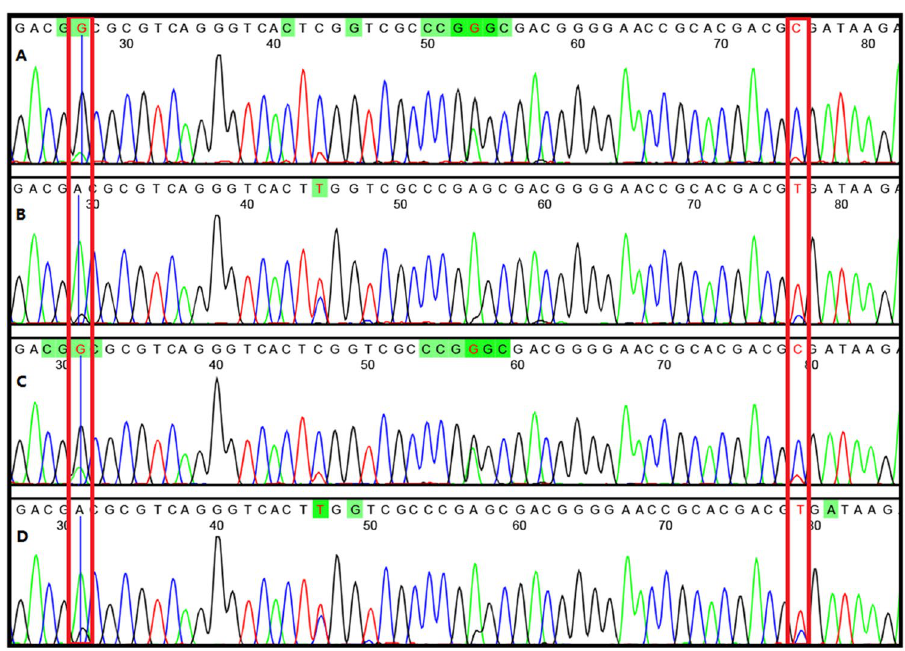
Figure 4. Double peaks of the artificial mixture of Lonicerae japonicae Flos and Lonicerae Flos from raw-plant powders. Note: Lonicerae japonicae Flos: Lonicerae Flos 15:1 ( A ) Lonicerae japonicae Flos: Lonicerae Flos 1:15 ( B ) Lonicerae japonicae Flos: Lonicerae Flos 4:1 ( C ) Lonicerae japonicae Flos: Lonicerae Flos 1:4 ( D ). Two SNP sites were framed in this peak profile,